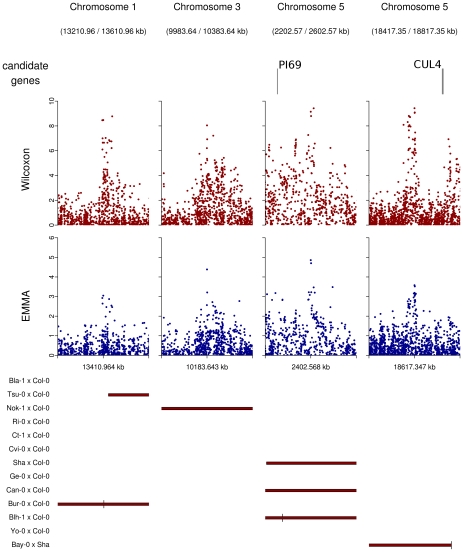
Peaks of associations with no candidate genes within a 20 kb region on either side of the top SNP (plotting window 400 kb).